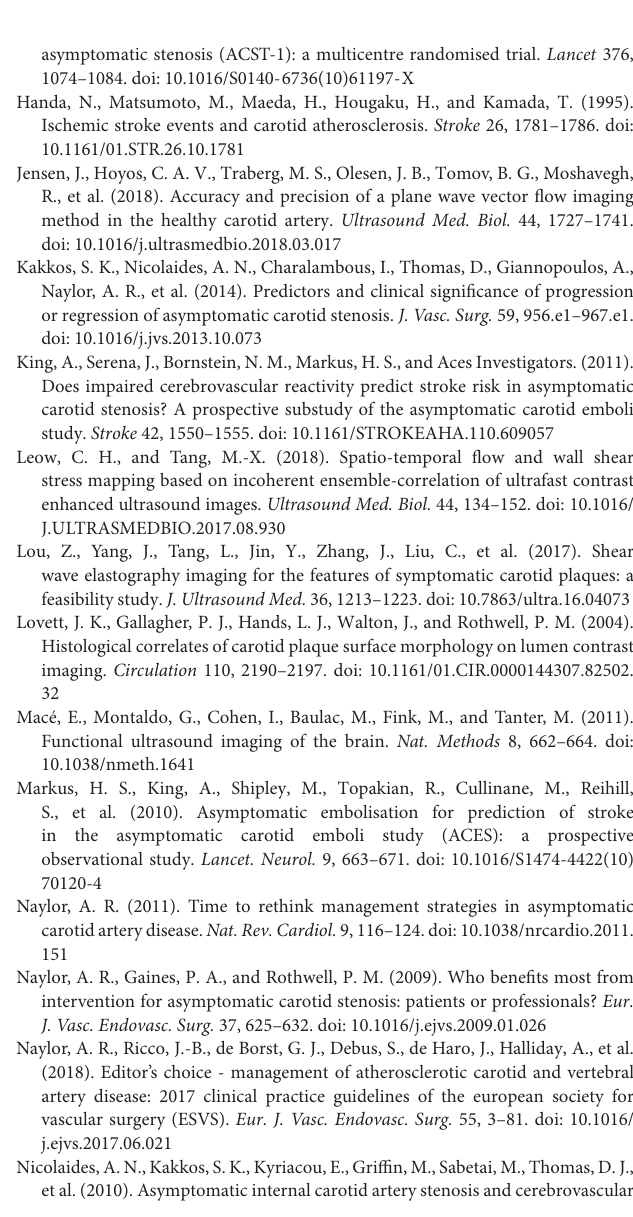
FIGURE S1 | Carotid plaque contouring visualized by different imaging modalities: B-mode ultrasound (A) , shear wave elastography (B) , ultrasensitive Doppler (C) , computed tomography (D) . The plaque is contoured on gross analysis after a longitudinal section of the carotid bifurcation (E) . The areas of calcifications (gray) and intra-plaque hemorrhage are shown on the carotid stenosis figure (F) . Ci, internal carotid; Cc, common carotid. VIDEO S1 | Evaluation of blood flow by Ultrafast Doppler at the carotid plaque level over the cardiac cycle. Representation of flow velocity vectors (1), wall shear stress (2), and micro-flow obtained with the ultra-sensitive Doppler sequence